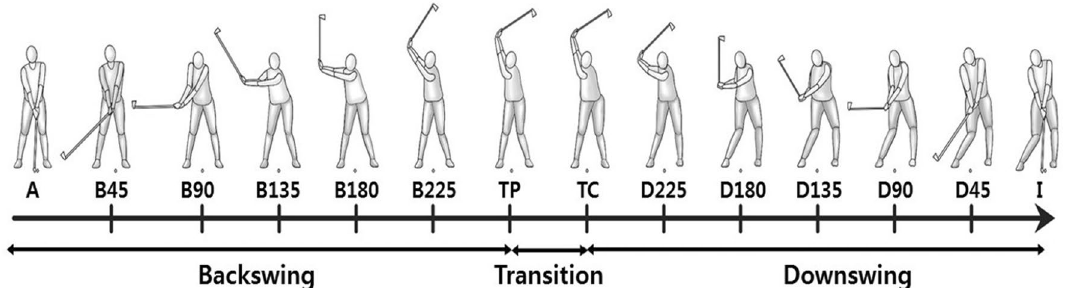
Figure 2. Fourteen sequential swing events identified in this study including address, 5 events during backswing, 2 events during transition to downswing, 5 events during downswing, and impact: Address (A), backswing 45° (B45), backswing 90° (B90), backswing 135° (B135), backswing 180° (B180), backswing 225° (B225), transition of the pelvis (TP), transition of the club (TC), downswing 225° (D225), downswing 180° (D180), downswing 135° (D135), downswing 90° (D90), downswing 45° (D45), and impact shaft in the YZ plane. Seventeen dependent variables were calculated at each of the 14 swing events as shown in Table 1. The following directions were considered as positive following the coordinate system shown in Fig. 1: vertical GRF, left foot lateral GRF, right foot medial GRF, anterior GRF, towards the target COP, anterior COP, open shoulder/pelvis angle in the transverse plane (left of the parallel to the target), trunk flexion angle in the sagittal plane, knee/ankle extension angle in the sagittal plane, towards the target COM, and anterior COM. Statistical analysis. To capture the average behaviour throughout the golf swing, we calculated the average over all five trials for each condition under each dependent variable. For statistical analysis, Statistical Parametric Mapping (SPM) 29–32 based on a random field theory was used to test statistical differences between ball positions using the open source (http://www.spm1d .org) MATLAB (Mathworks Inc., Natick, USA) code. SPM allows for non-directed hypothesis test and helps to control Type 1 error by reducing the number of statistical testing of one-dimensional data (i.e. 14 continuous swing events in our study). More details about the method can be